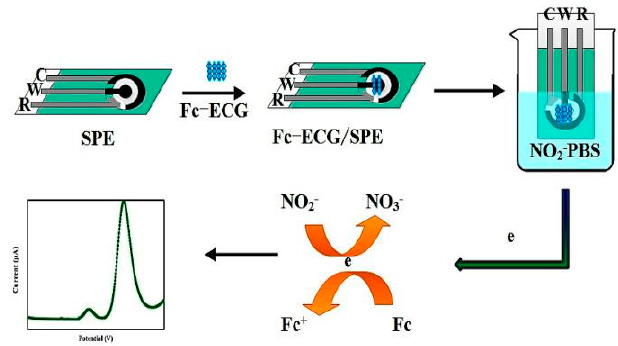
Figure 1. Fabrication of Fc-ECG/SPE electrochemical sensor for nitrite detection by DPV.